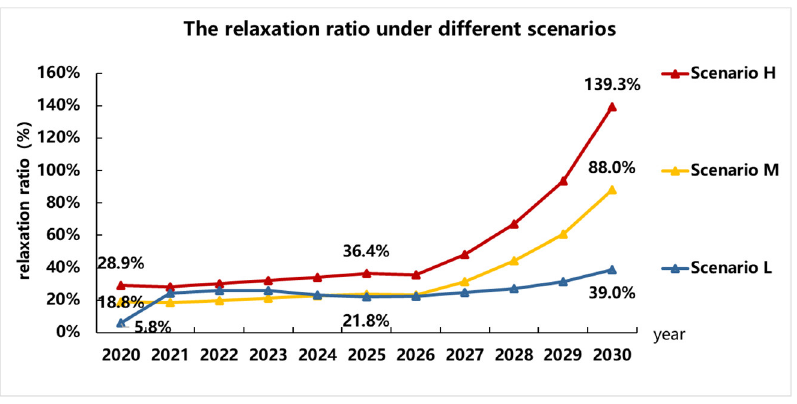
Figure 4. Average fuel consumption under different scenarios.